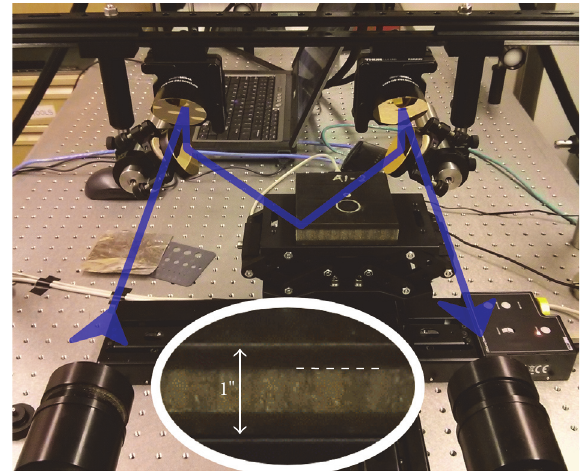
Figure 5: Sample tile “ A1-8 ” positioned ready for scanning. The two black cylinders on the left and right are the Te fl on-collimating lens enclosures of the THz emitter and detector, respectively. The path of the THz beam is highlighted in blue. Upon exiting the transmitter the THz radiation is linearly polarized horizontally across the optical table. The rectangular tile sample is positioned on top of a precision lab jack and two X - Y positioning stages. Oval inset: an edge closeup of the three-layered tile sample. The dashed horizontal line indicates the target depth of the re fl ection imaging at the fi rst rubber-rubber